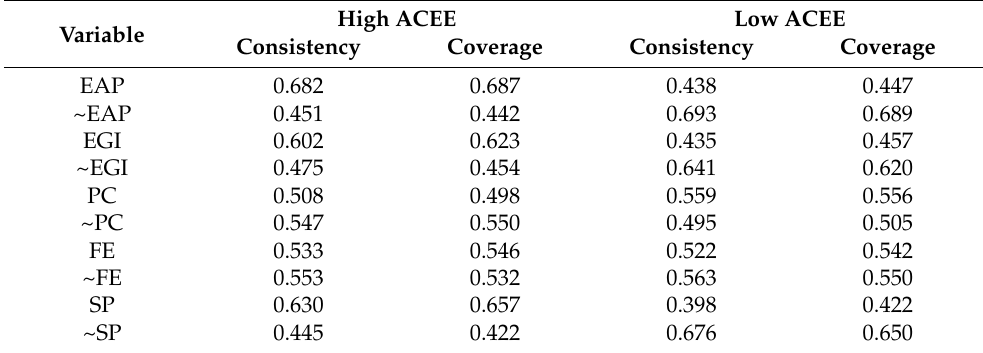
Table 6. Necessity analysis of single factors.